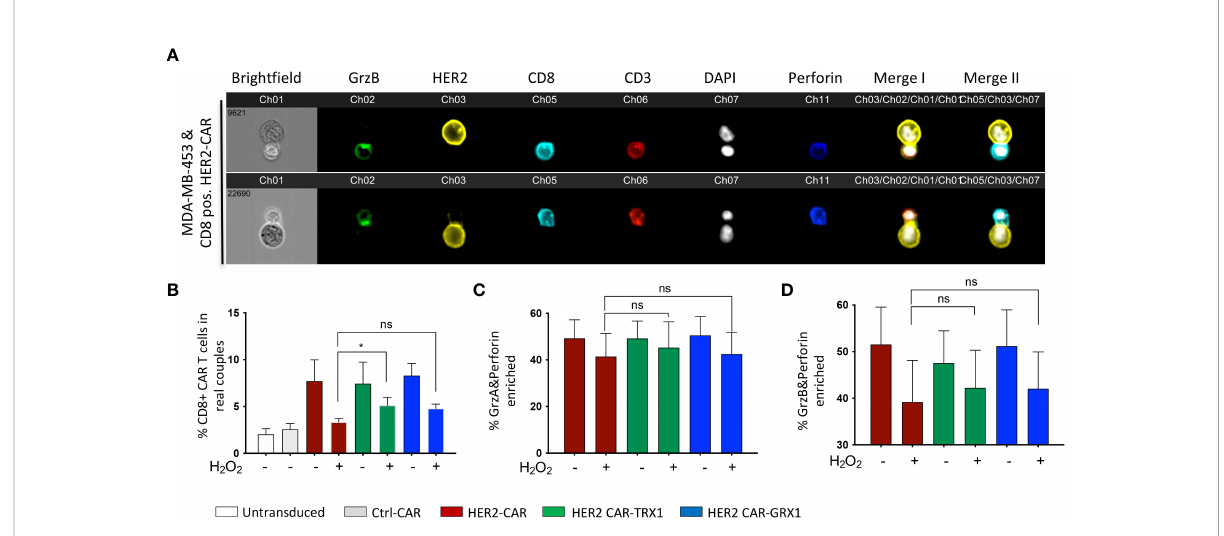
FIGURE 2 TRX1-expressing CAR T cells retain their capacity to form cytolytic synapses under pro-oxidative conditions. (A) Representative images of cytolytic immune synapses between CD8+ HER2-CAR T cells and MDA-MB-453 tumor cells. CAR T cells were untreated or pretreated with H 2 O 2 for 30 min, then cocultured with MDA-MB-453 (1:1 ratio, 15 min). Cells were fi xed and stained for granzyme B (green), HER2 (yellow), CD8 (cyan), CD3 (red), nuclei (DAPI, white), and perforin (blue). Merged images of CD3, HER2 and DAPI (merge I) and CD8, HER2 and DAPI (Merge II) are shown. (B) % CD8+ CAR T cells in synapses with MDA-MB-453 tumor cells. Data represent mean ± SEM (n ≥ 3; * p < 0.05, ns = non-signi fi cant). (C, D) Quanti fi cation of enrichment of (C) granzyme A and perforin, and (D) granzyme B and perforin at the immune synapse. Data represent mean ± SEM (n ≥ 3; * p <